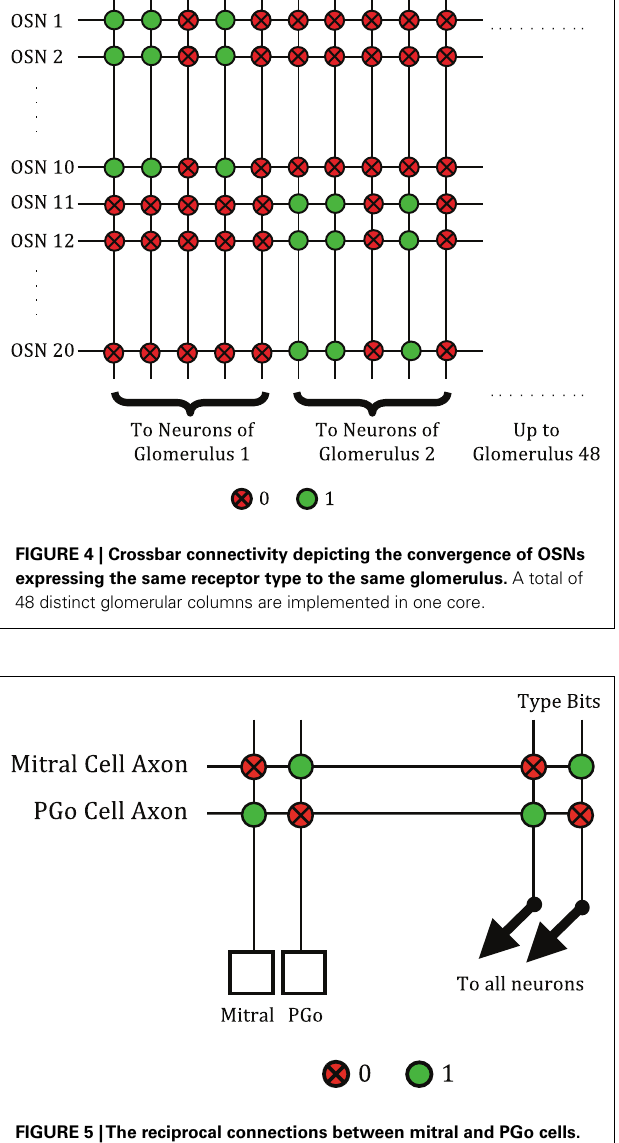
FIGURE 5 |The reciprocal connections between mitral and PGo cells. Spikes from the mitral or PGo cell are sent off-chip by the AER transmitter and routed back to the appropriate axon.The mitral cell is configured so that a “10” type synapse is given a negative weight during synaptic integration. The spike of a PGo cell is routed to its axon in the crossbar which is configured to have a “10” type connection to inhibit the mitral cell. Similarly, the PGo cell is configured so that a “01” type synapse is given a positive weight.The mitral cell axon produces this type of synapse with the PGo cell to excite